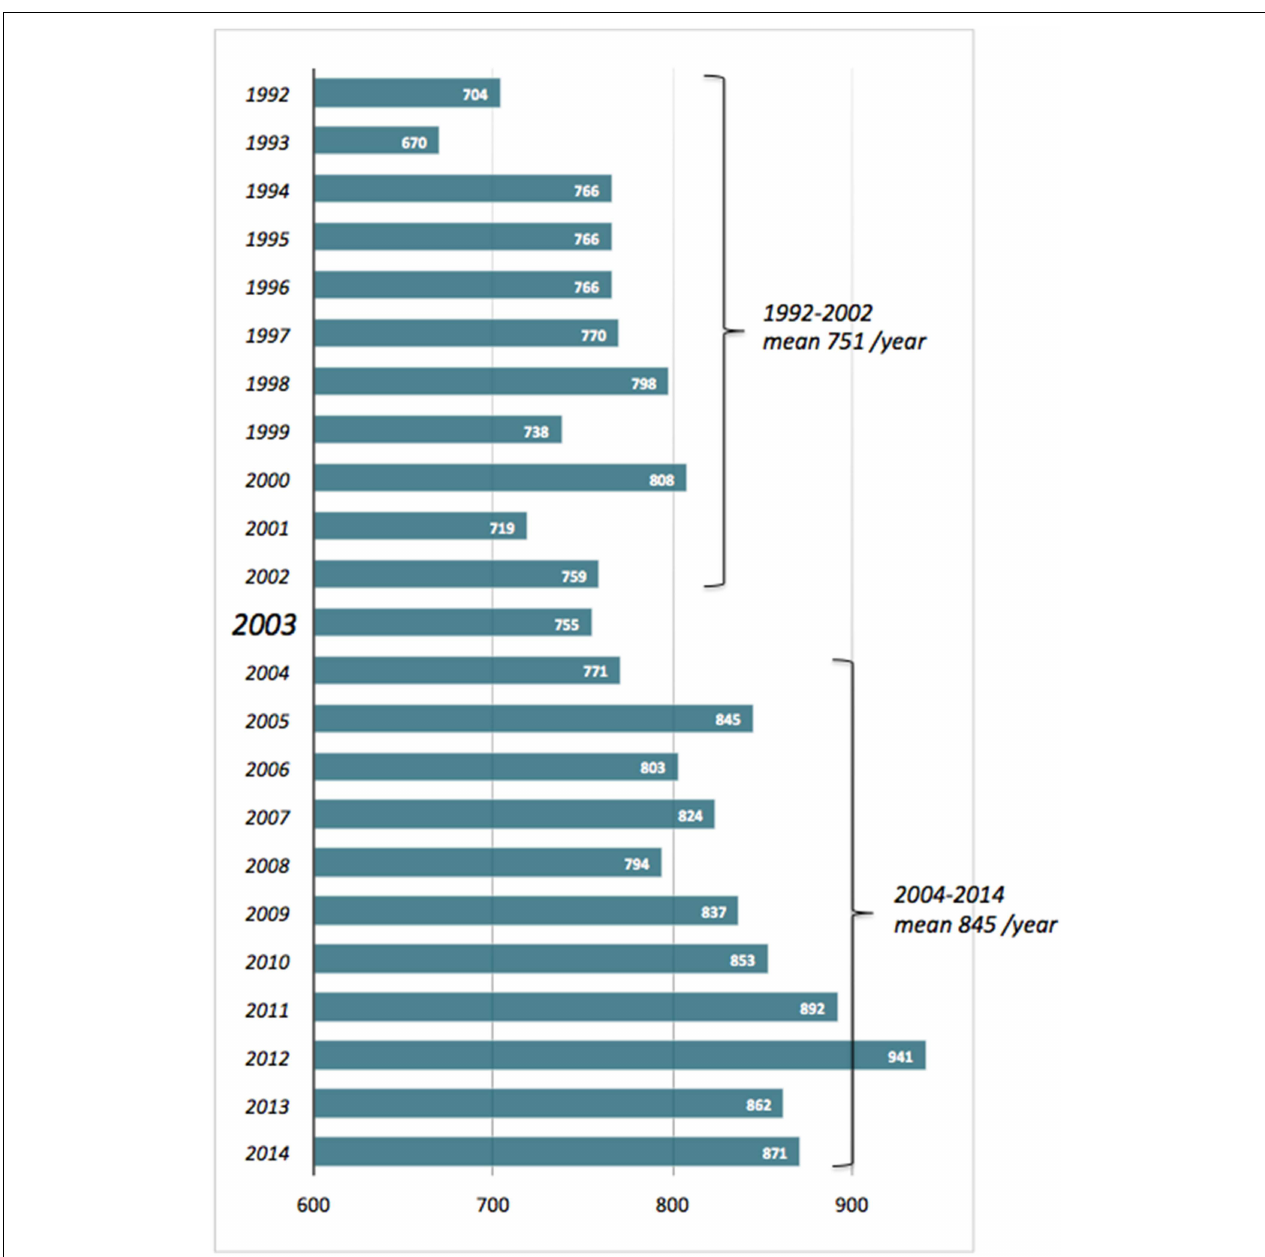
FIGURE 1 | No. of scientific papers published in the period 1992–2014 and quoting “glutathione” as title word. Source: Entrez PubMed, http://www.ncbi.